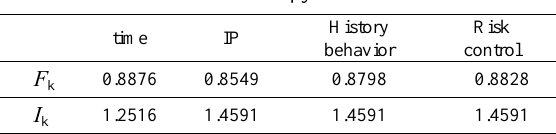
Table 6. Factor’s history record classification and information